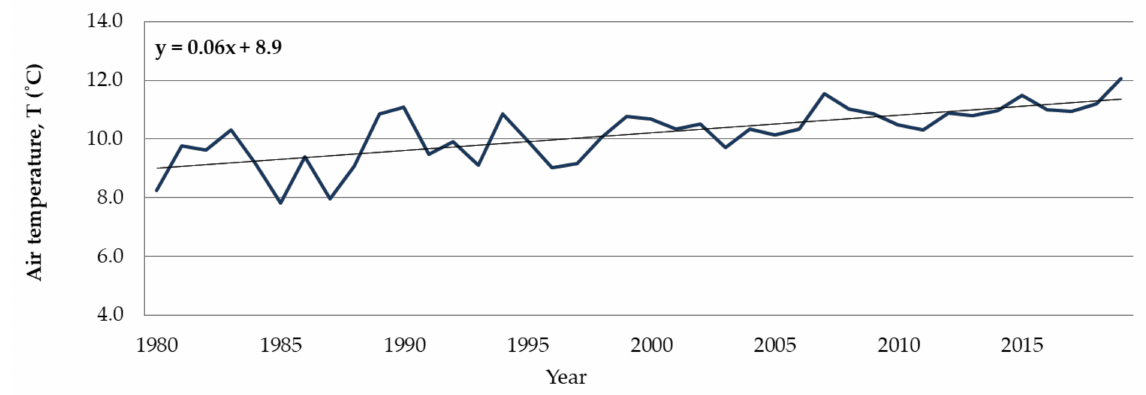
Figure 12. Average annual air temperature in the catchment area of the Middle and Lower Dniester, T ( ◦